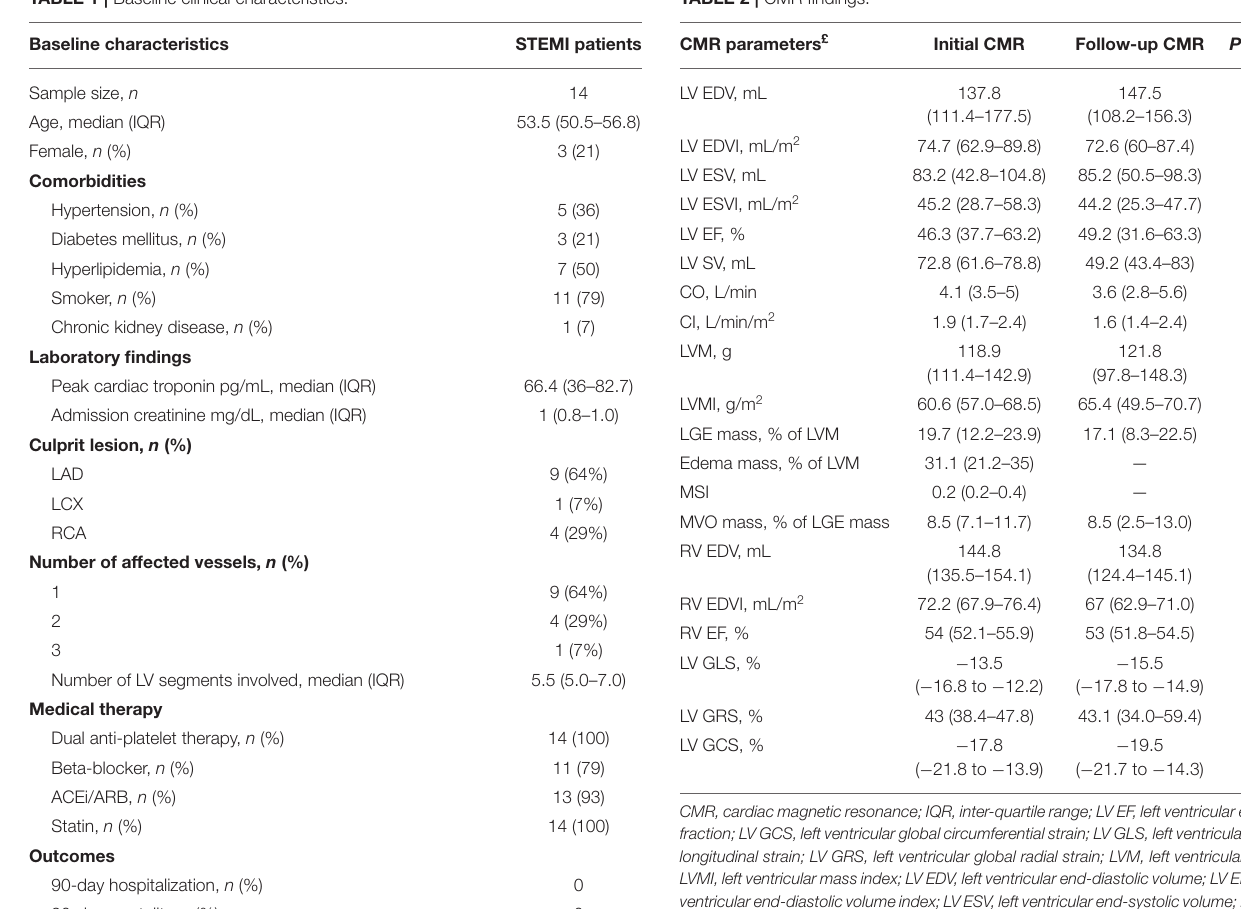
TABLE 1 | Baseline clinical characteristics. TABLE 2 | CMR